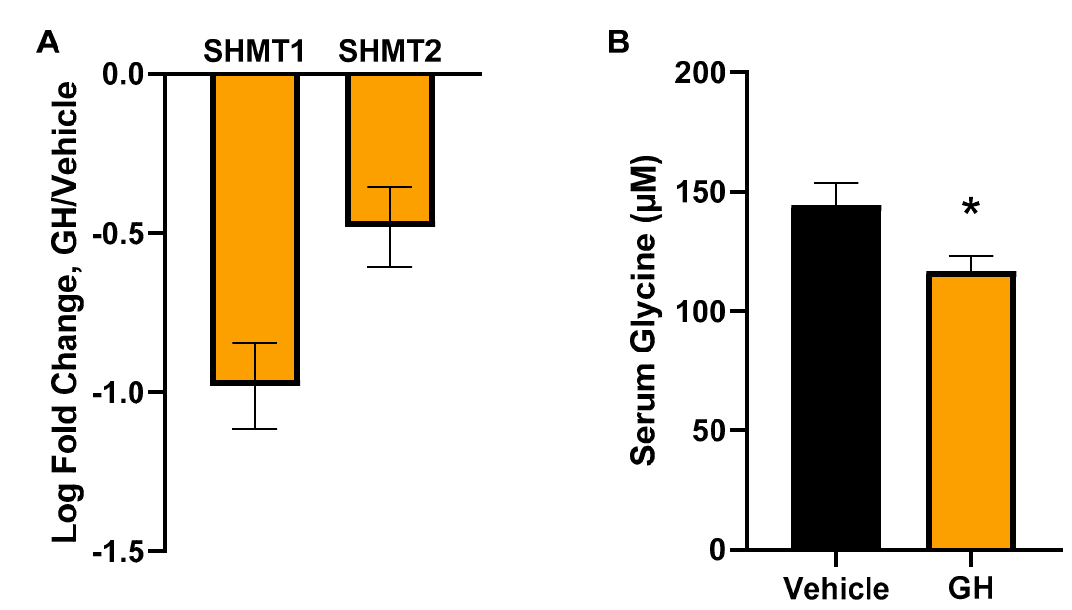
Figure 2. Glycine synthesis and disposal. ( A – D ) Liver RNA expression of genes associated with glycine synthesis ( A , B ) or catabolism ( C , D ) in male and female bGH mice and littermate WT controls and GHRKO mice and littermate WT controls. ( E ) Fecal concentration of glycine in male and female bGH and GHRKO mice and controls. * indicates t -test p < 0.05 comparing each experimental group to sex-matched littermate WT.